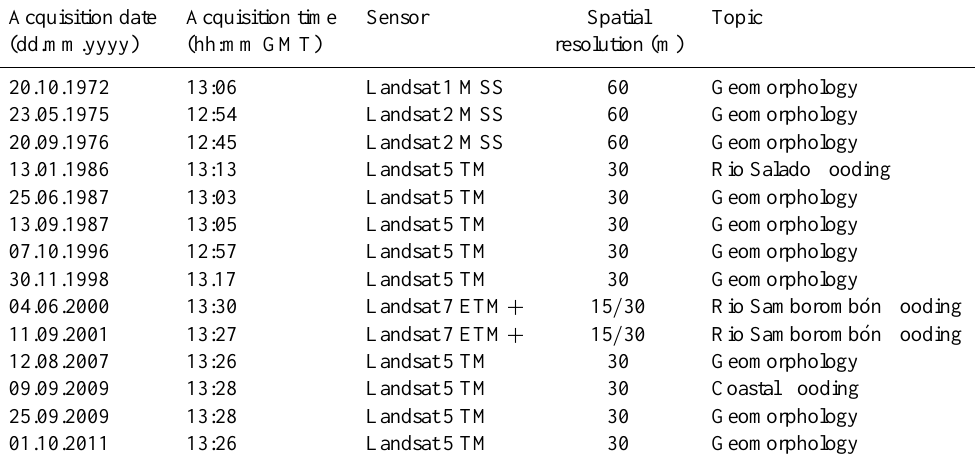
Table 1. Satellite images used in the study to investigate the geomorphological evolution of Samboromb´on Bay and the flooding of the